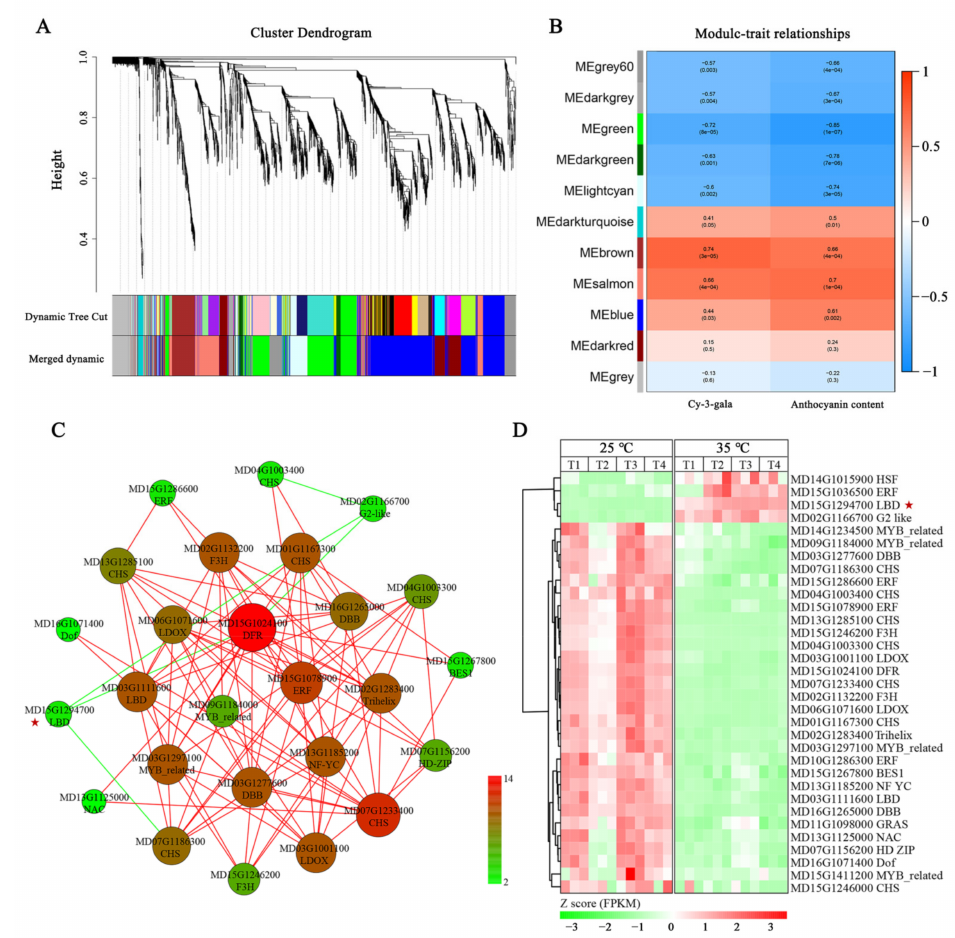
Figure 5. Weighted gene co-expression network analysis (WGCNA) of DEGs in apple at 25 ◦ C and 35 ◦ C treatment. ( A ) Hierarchical cluster tree presenting modules of co-expressed genes with color annotation. ( B ) Module–anthocyanin correlations and corresponding p -values. The left panel shows eleven modules. The color scale on the right displays module-trait correlation from − 1 (blue) to 1 (red). ( C ) Connection network between 12 anthocyanin structural genes and 21 TFs (transcript factors) in the ‘green’ module. The coefficients were calculated from log2 (fold change) of each transcript using the EXCEL program. This study selected correlations with a coefficient of R2 > 0.9. Positive correlations are presented with red lines, while negative correlations are presented with green lines. The color scale on the right shows anthocyanin structural gene-TF correlation numbers from 2 (green) to 14 (red). The correlation relationships were visualized using Cytoscape (version 2.8.2). ( D ) The heat map for the expression of 12 anthocyanin structural genes and 21 TFs (transcript factors) in the ‘green’ module. The numerical values for the green-to-red gradient bar indicate the log2-fold change relative to the control sample. The red pentagram indicates MdLBD37